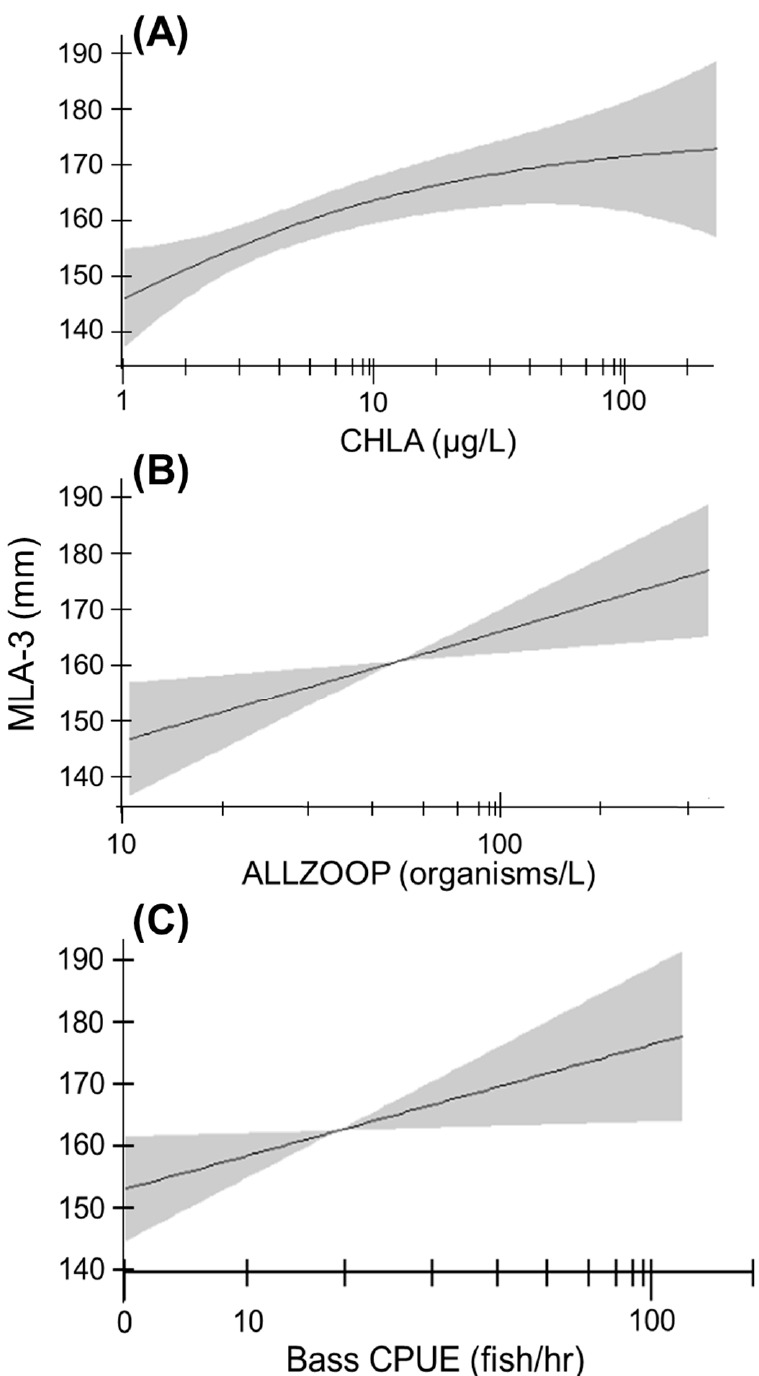
Figure 4. Generalized additive model relating Bluegill mean back-calculated length at age 3 (MLA-3, mm) to ( A ) chlorophyll- a concentration (CHLA, µ g/L, p = 0.007), ( B ) total zooplankton density (ALLZOOP, organisms/L, p = 0.009), and ( C ) stock-length Florida Bass catch per unit effort (Bass CPUE, fish/h, p = 0.031) in Florida lakes. Shaded areas are 95% confidence intervals.